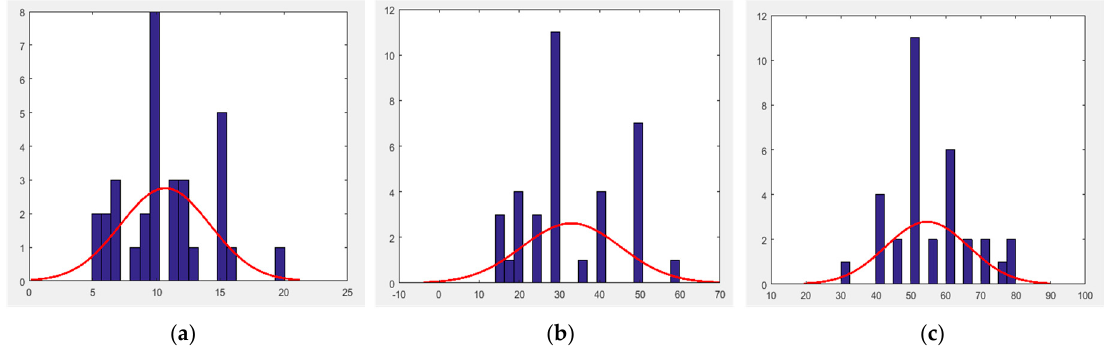
Figure 5. Normal distribution of fuzzy distance cognition. ( a ) 10 m; ( b ) 30 m; ( c ) 50 m.